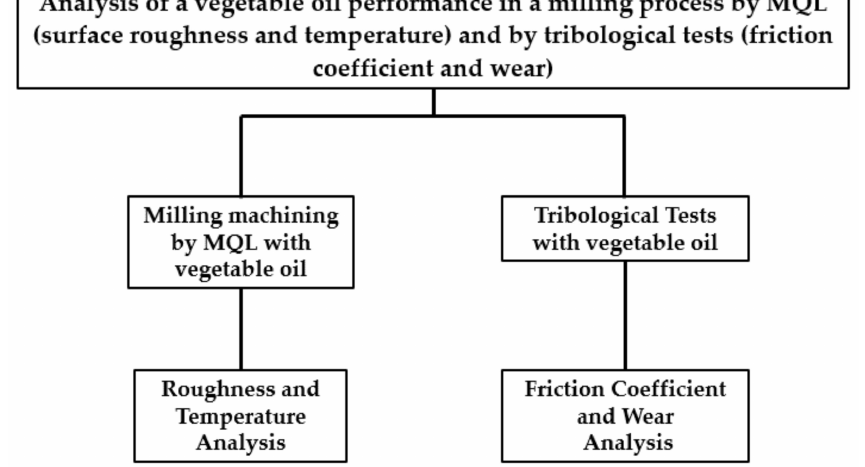
Figure 1. Diagram of the performed